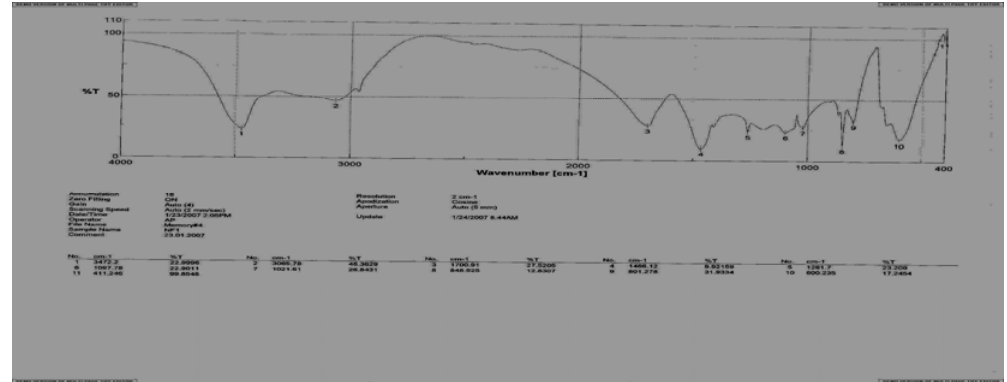
Figure 3. IR spectrum of the α -[ N -di-( β -chloroethyl)-amide] of N'-( meta - formylaminobenzoyl)- D,L -methionine ( 18 ).